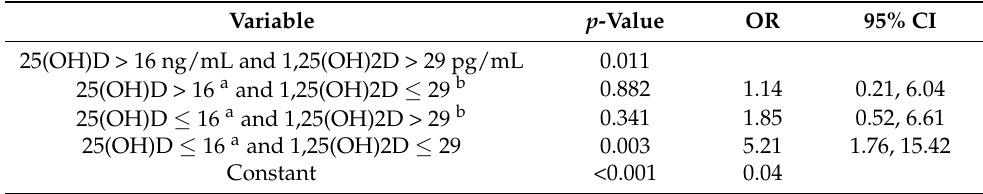
Table 3. Risk according to levels of 25(OH)D combined with